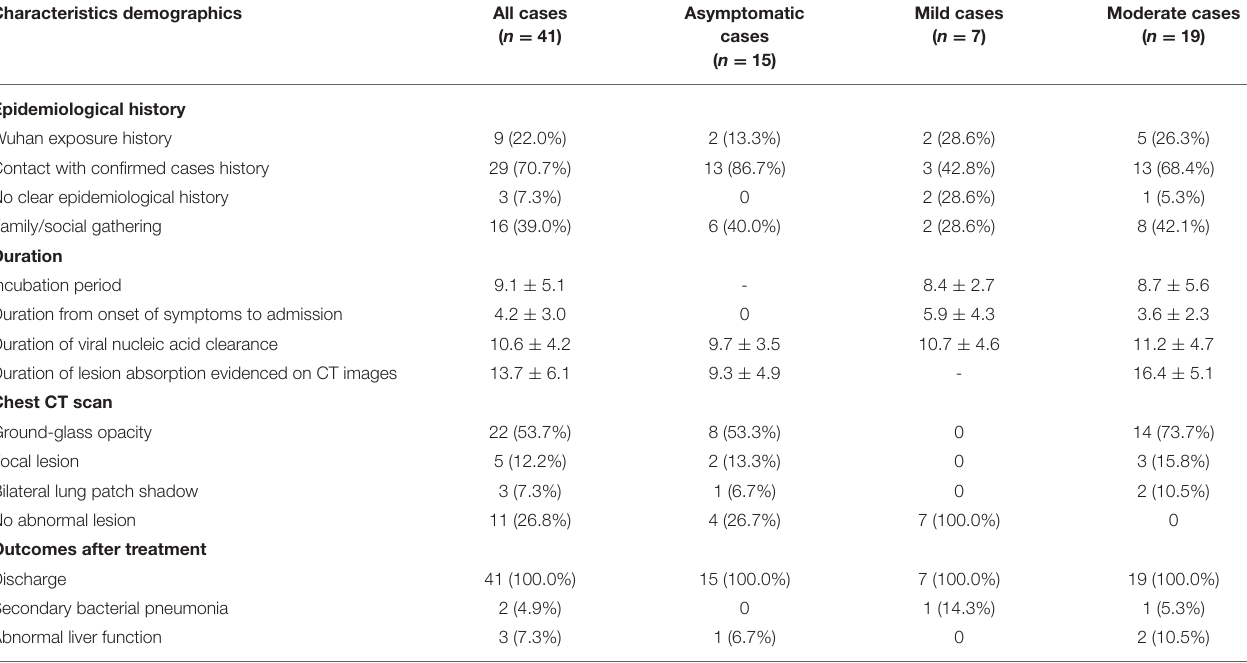
TABLE 2 | Epidemiological history, chest CTs, and outcomes of 41 patients with COVID-19. Characteristics